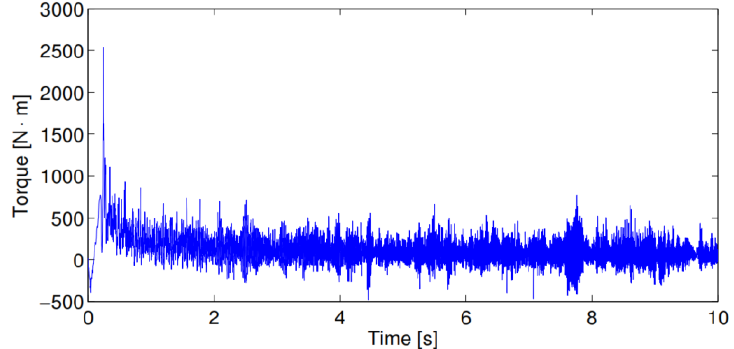
Figure 17. The optimal dynamic torque provided by the in-wheel AFSRM.